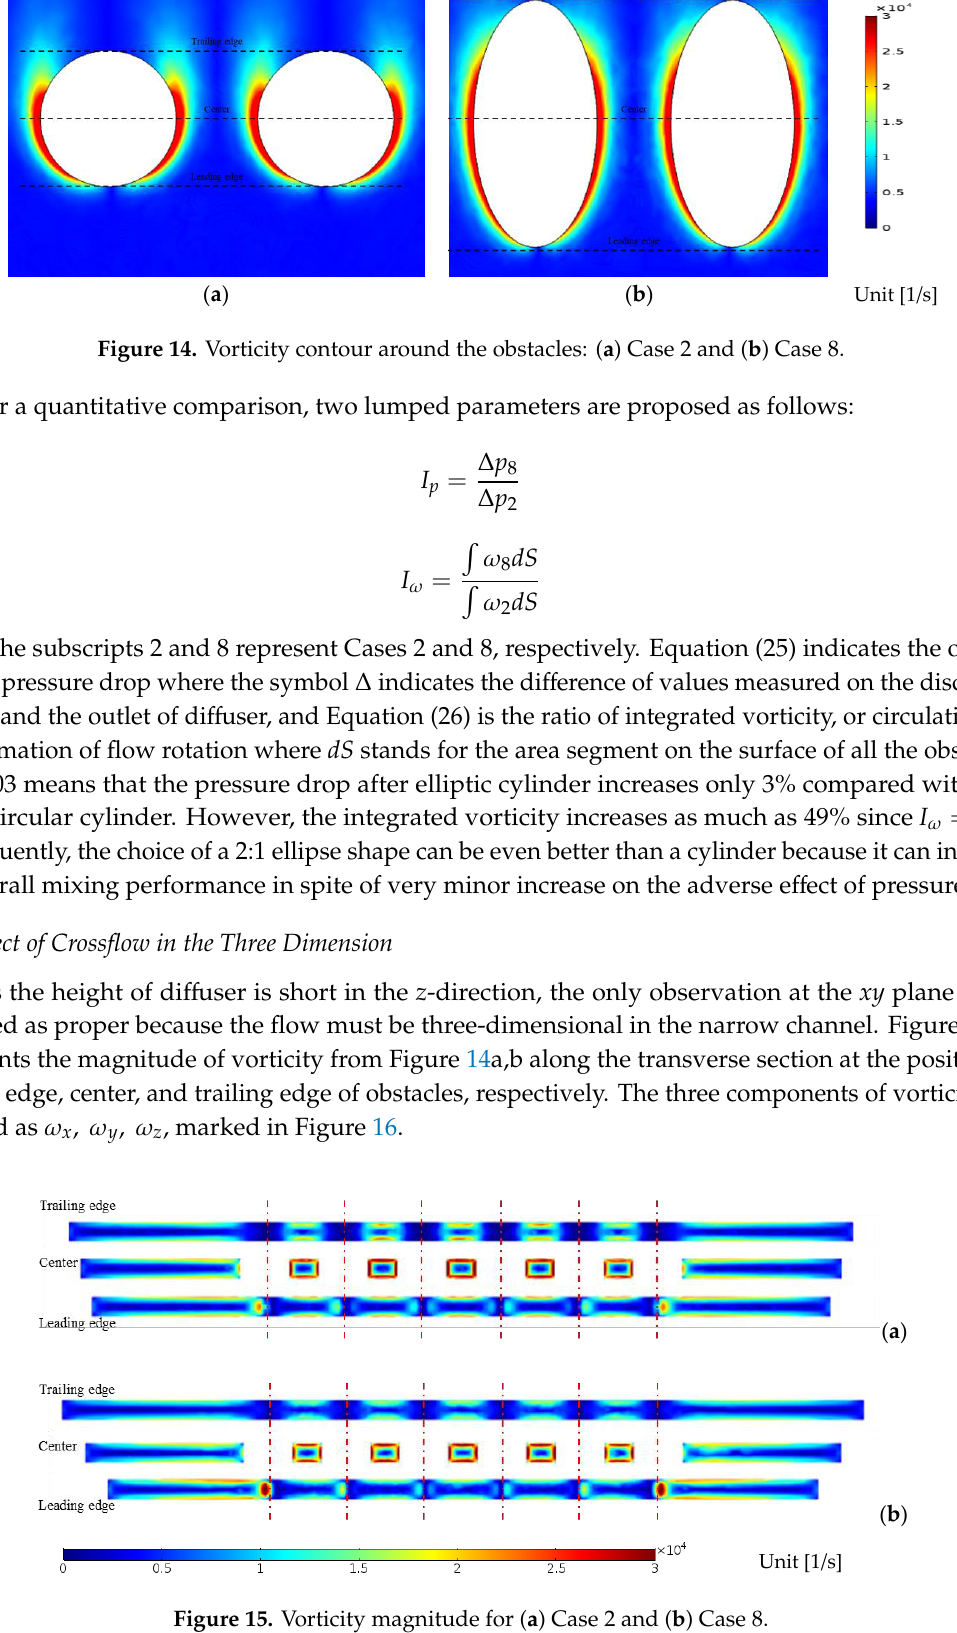
Figure 16. Schematic of the three-dimensional vortices around obstacle. The 𝜔 𝑧 effects obviously on the two-dimensional uniformity mentioned in the previous section, but the narrow gap between upper and lower plates of diffuser results in 𝜔 𝑥 , which is almost independent on the existence of obstacles. However, the crossflow or three-dimensional effect can be found in Figure 15a,b where it is denoted as 𝜔 𝑦 , consisting of a horse sue figure of vortex filament with 𝜔 𝑥 in Figure 16. The strength of them is compared in Figure 17a–f where 𝜔 𝑦 is only marked significant at the leading edge position, but is diffused at the downstream: see Figure 17b,e. In Figure 17a–f, the magnitudes of 𝜔 𝑥 and 𝜔 𝑧 seems to be similar orders. Overall, the magnitudes are compared as 𝜔 𝑥 ≈ 𝜔 𝑧 > 𝜔 𝑦 , and, therefore, the vorticity components 𝜔 z (major) and 𝜔 y (minor) contributes to the mixing with the installation of obstacles inside the diffuser.